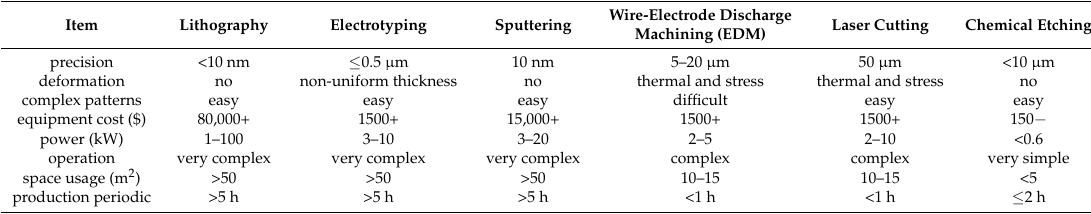
Table 1. Comparison of different manufacturing